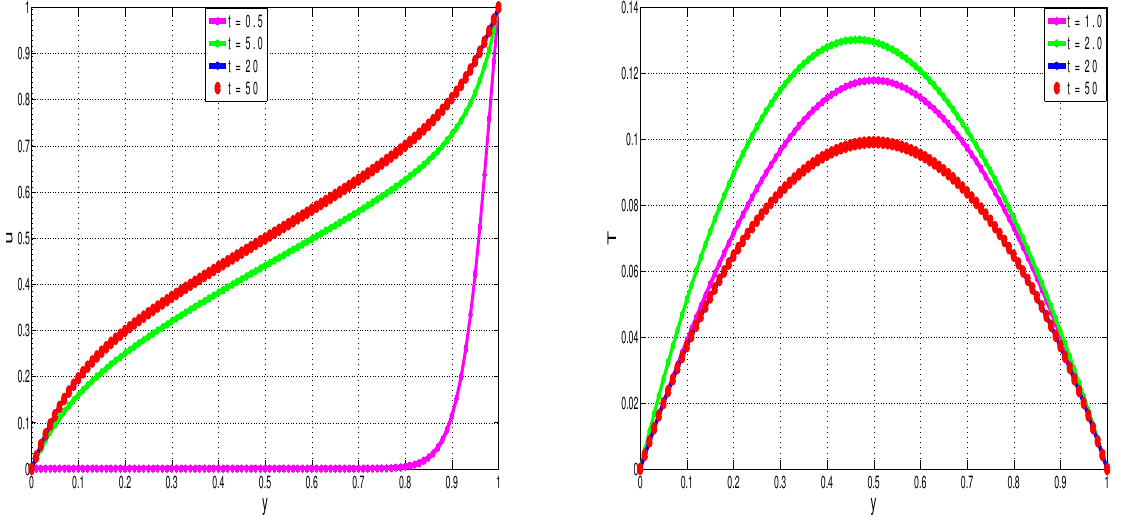
Figure 11. Development of steady velocity profiles ( left ) and temperature profiles ( right ) with β = 0.95, ε = 2.